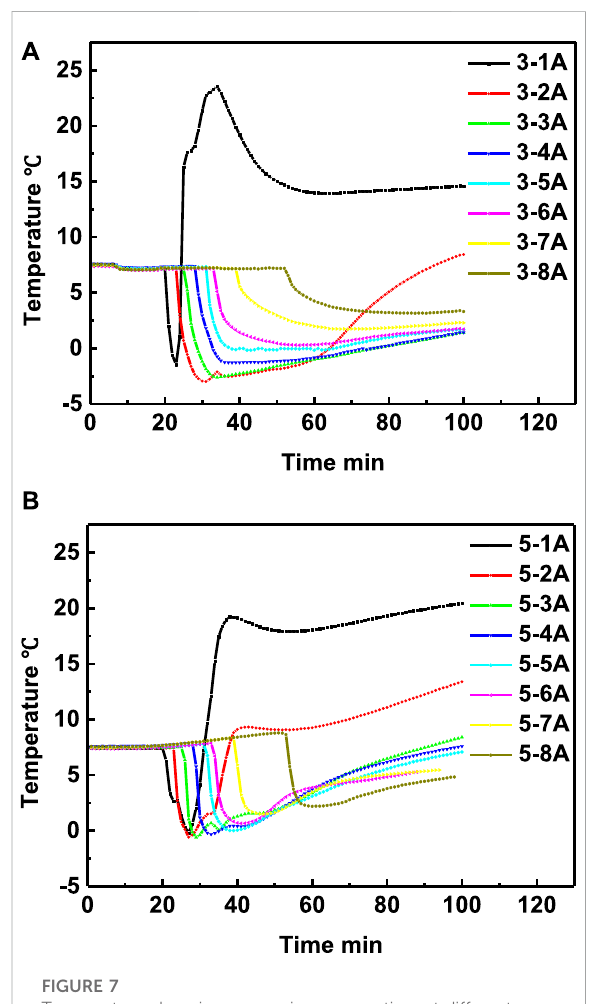
FIGURE 7 Temperature changing comparison versus time at different positions of experiment 3 (A) and experiment 5 (B) ,